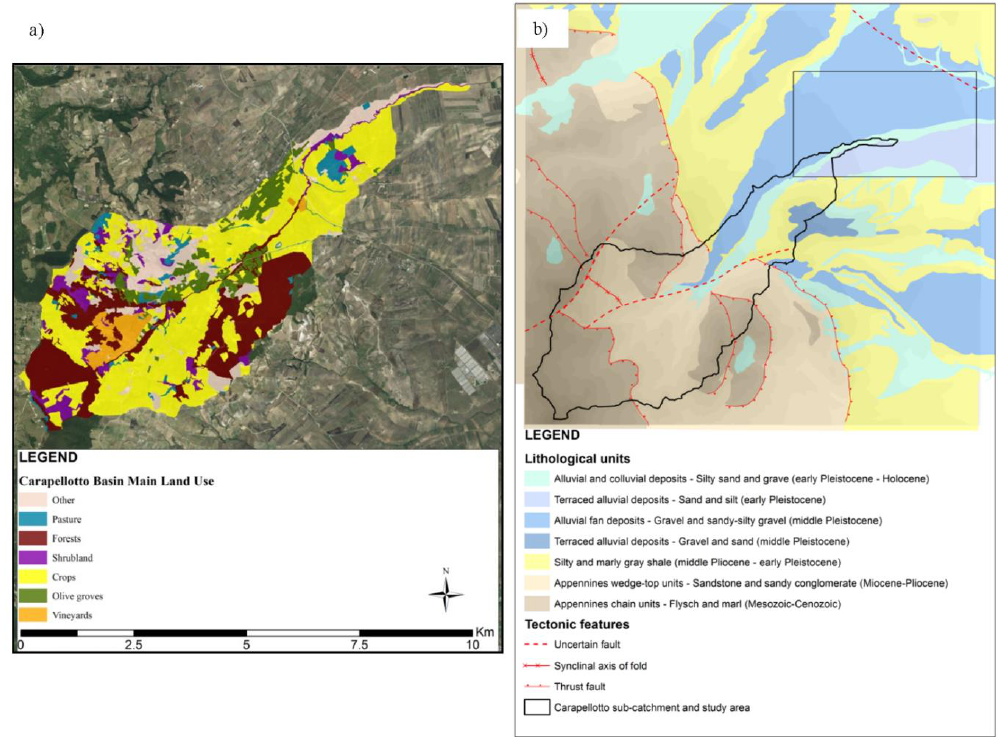
Figure 2. Land-use of the basin ( a ) and lithological map of the study area ( b ). The black lined rectangle indicates the area of groundwater and surface water monitoring.